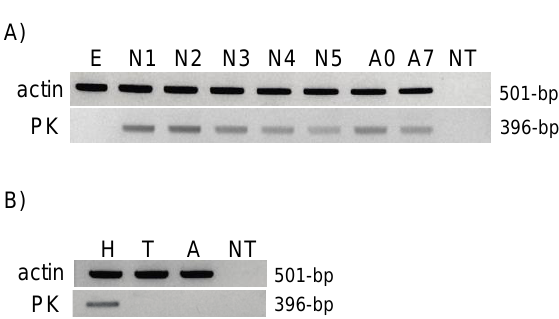
Figure 4. Endpoint RT-PCR expression profile of the LyghePK transcript. ( A ) Expression across L. hesperus development. Abbreviations: egg, E; 1st–5th instar nymphs are N1-N5, and adults aged 0 and 7 days post-eclosion are A0 and A7. ( B ) Expression in mixed sex adult body segments. Abbreviations — H, head; T, thorax; A, abdomen. NT denotes reactions lacking a cDNA template.